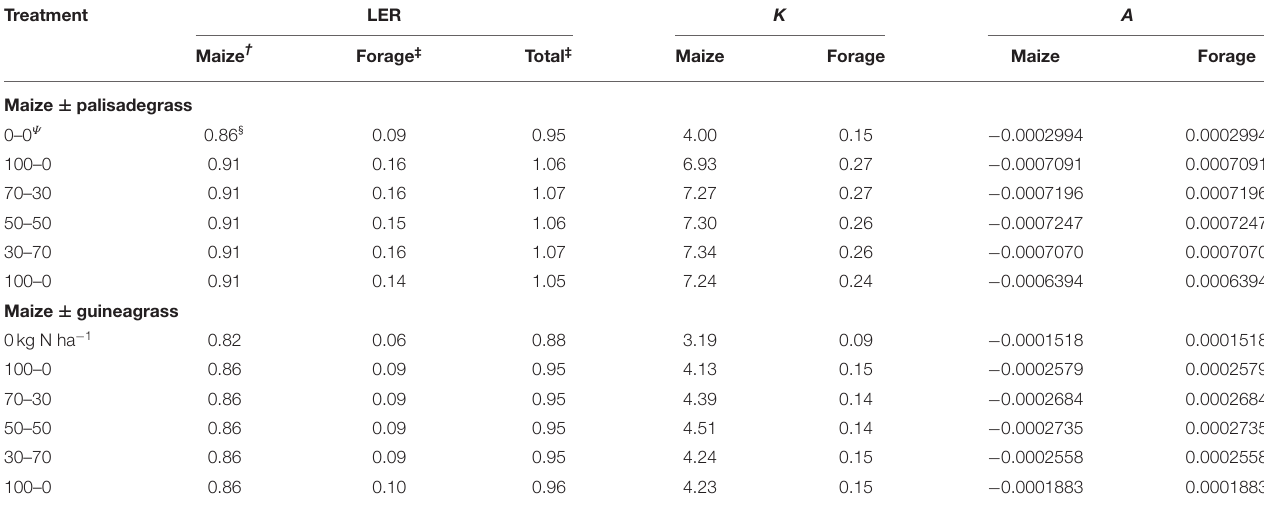
TABLE 4 | Land equivalent ratio (LER), relative crowding coefficient ( K ), and aggressivity ( A ) of maize, palisadegrass, and guineagrass intercropped as a function of N fertilizer applied for maize crop.